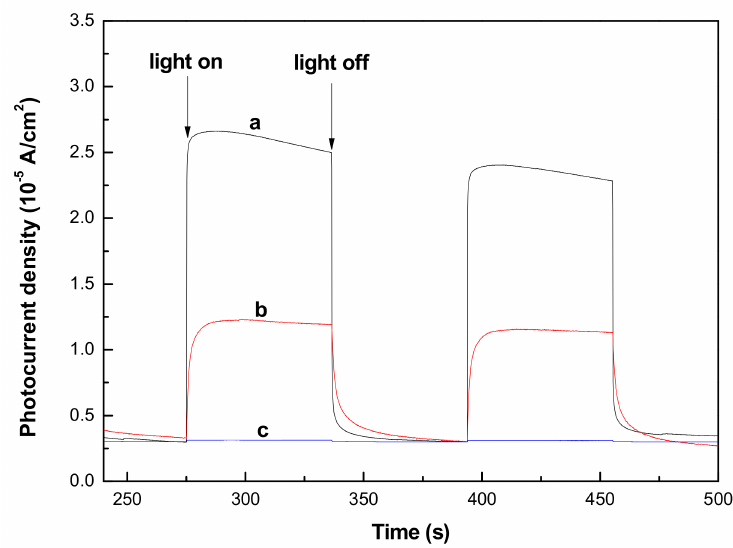
Figure 5. Transient photocurrent responses of ZnS-GQDs (a), ZnS-graphene (b) and pure ZnS (c). Table 1. The photocurrent density value of ZnS-GQDs, ZnS-graphene and pure